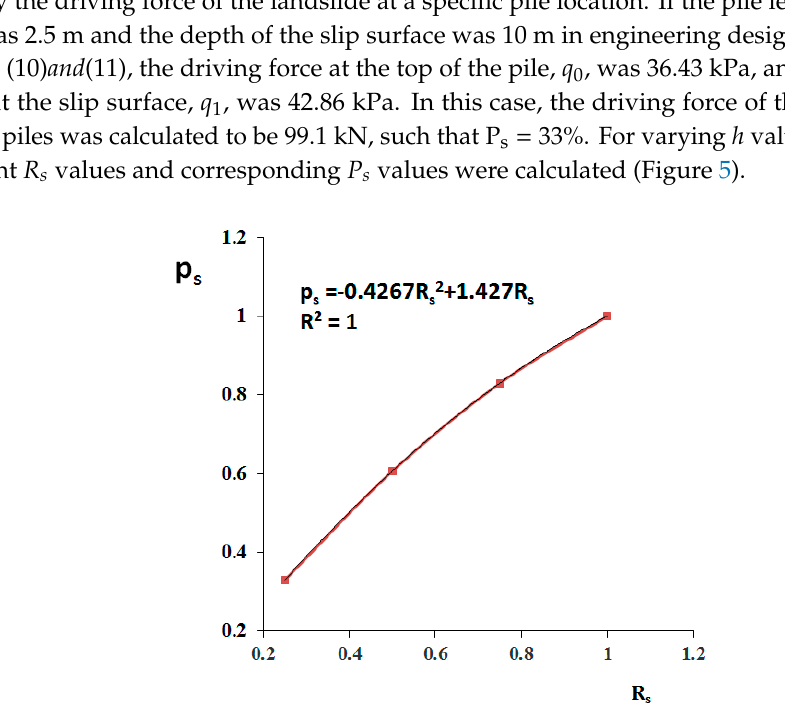
Figure 5. Relationship between the driving force of the pile-shared ratio and the buried depth